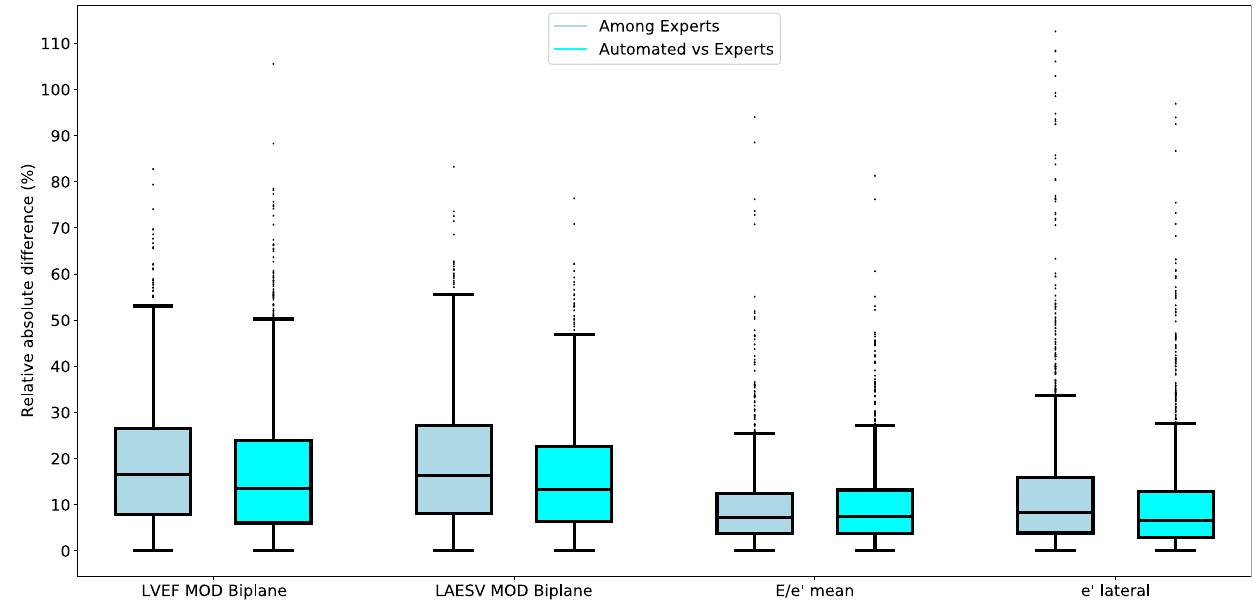
Fig. 2 | Box plot showing the relative absolute differences for four key para- meters among expert sonographers and between automated readings and expertsonographers. Relativeabsolutedifferenceamonghumans(darkblue)and between automated measurements and humans (light blue). The box plots centre line refers to the median. The box ’ bounds re fl ect the 25 th and 75 th percentile. The